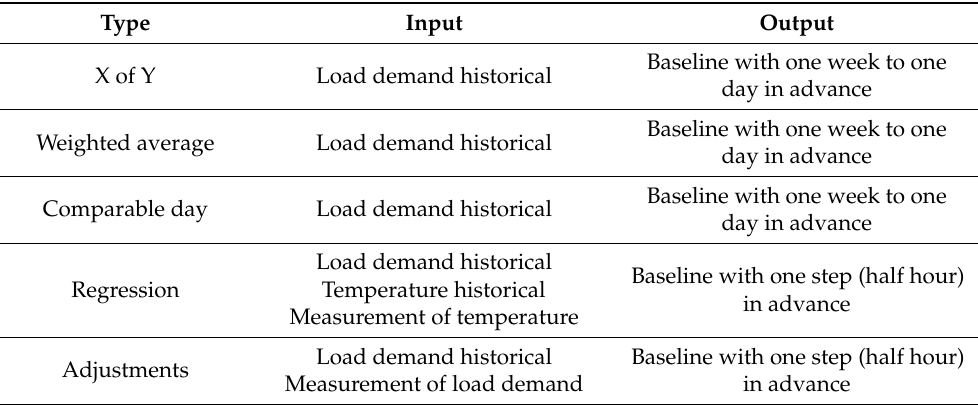
Table 2. Inputs and outputs of baseline